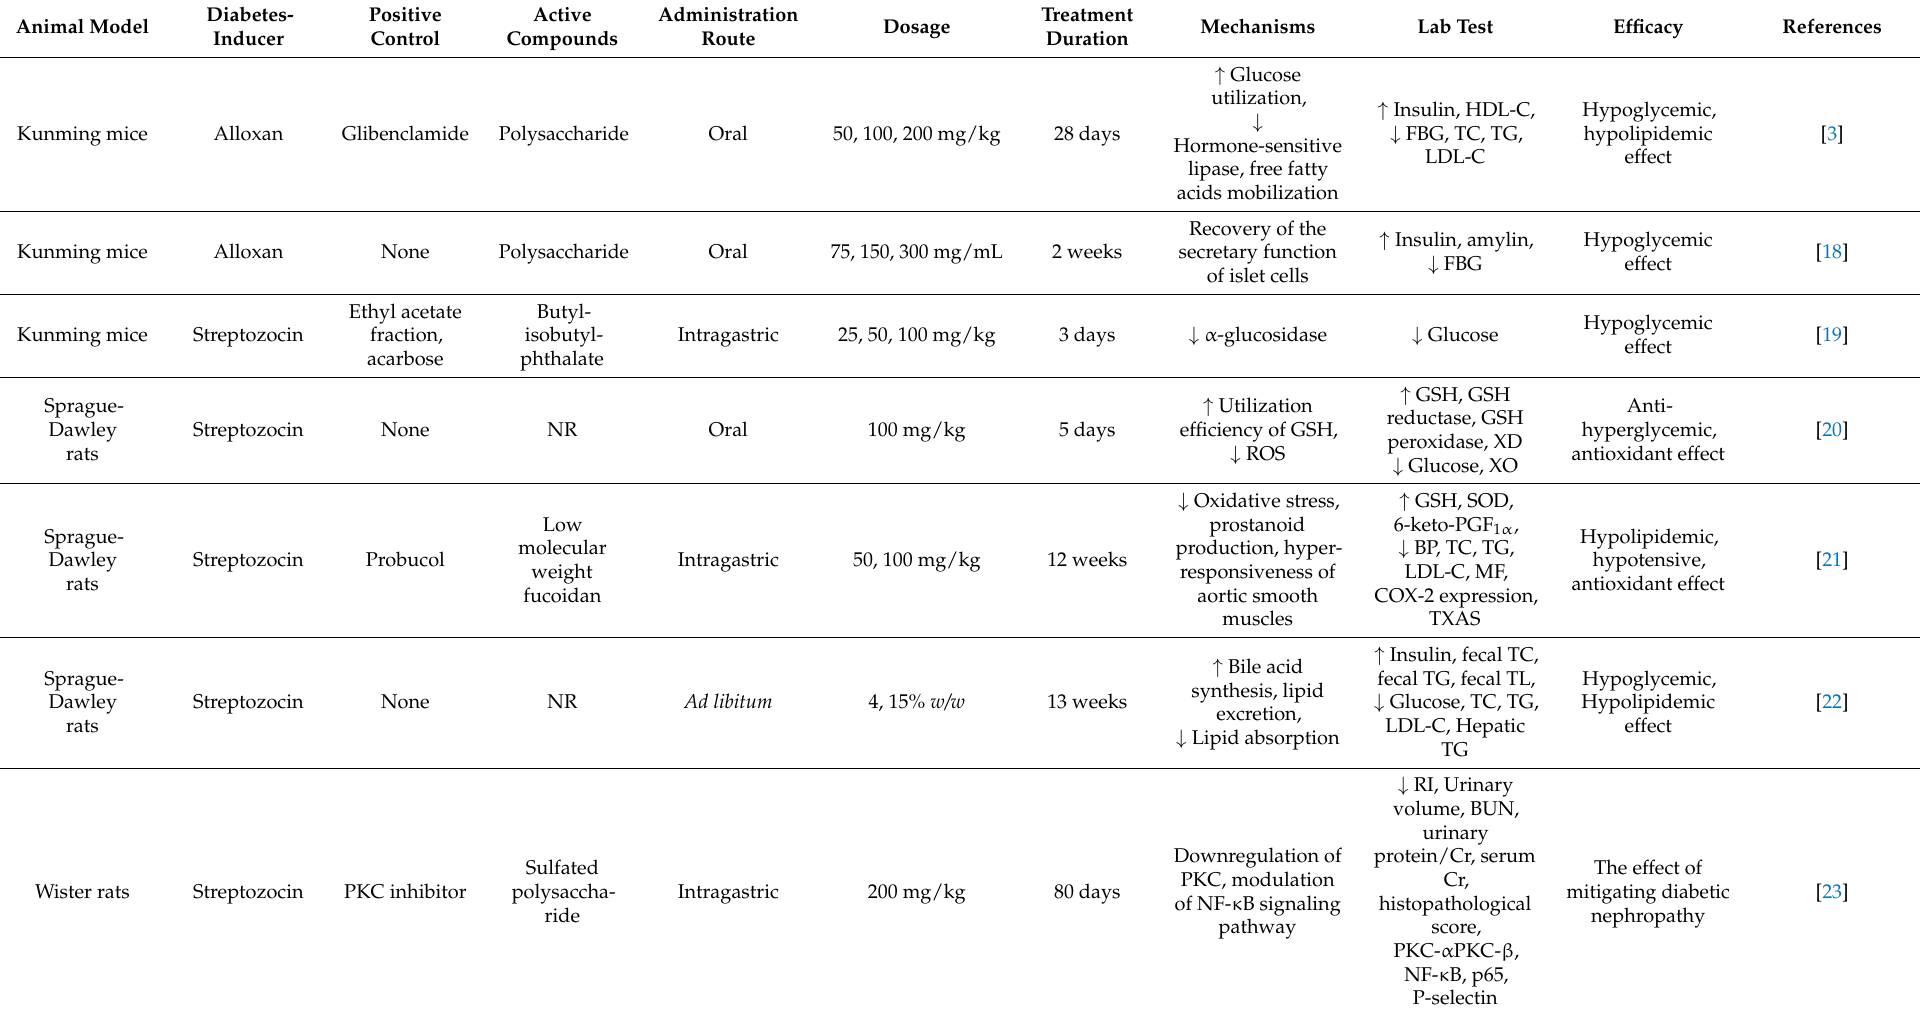
Table 1. An overview of the included in vivo studies on the efficacy of LJP on